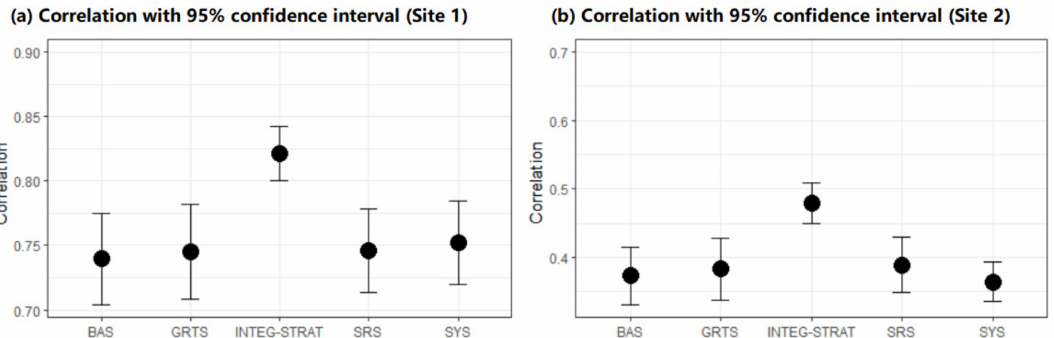
Figure 7. The mean and upper and lower correlations with 95% CI for five strategies with the sampling size ranging from 20 to 200 at both sites (the black points represent the mean value of correlation coefficients and short horizontal line represents the upper and lower values with 95% CI).